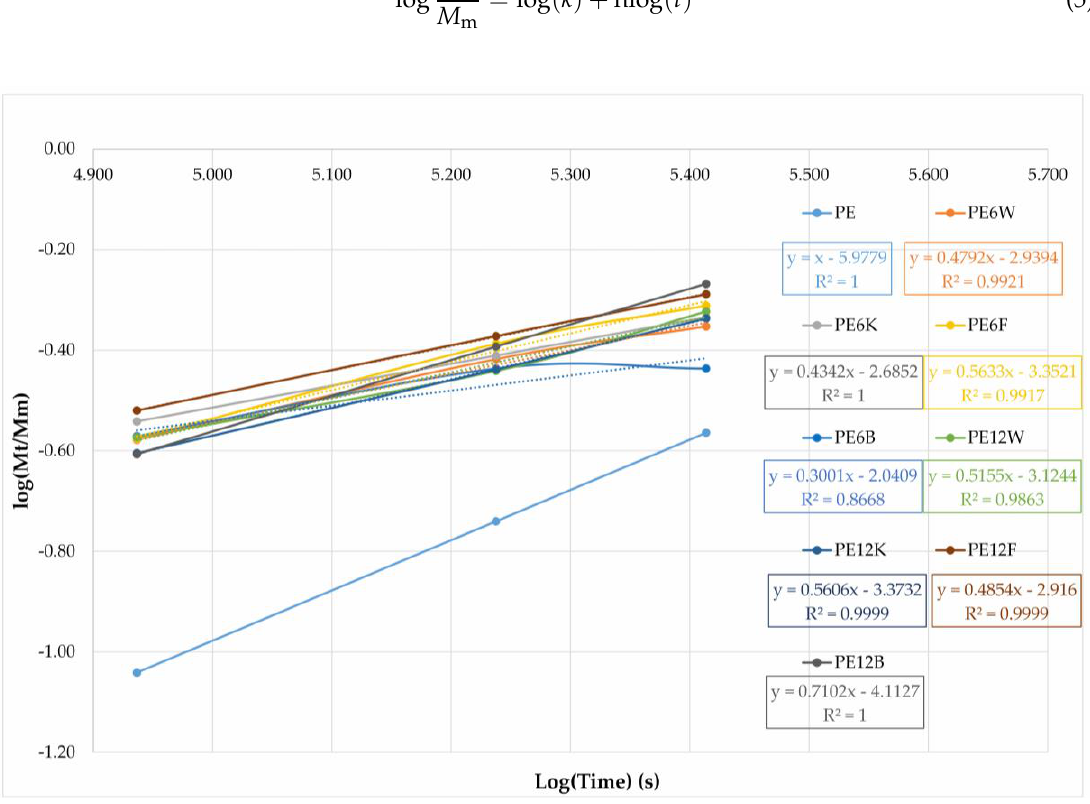
Figure 11. Calculated experimental data to estimate parameter n associated with the diffusion mode. Table 6. Estimated parameters for diffusion coefficient and its kinetics .